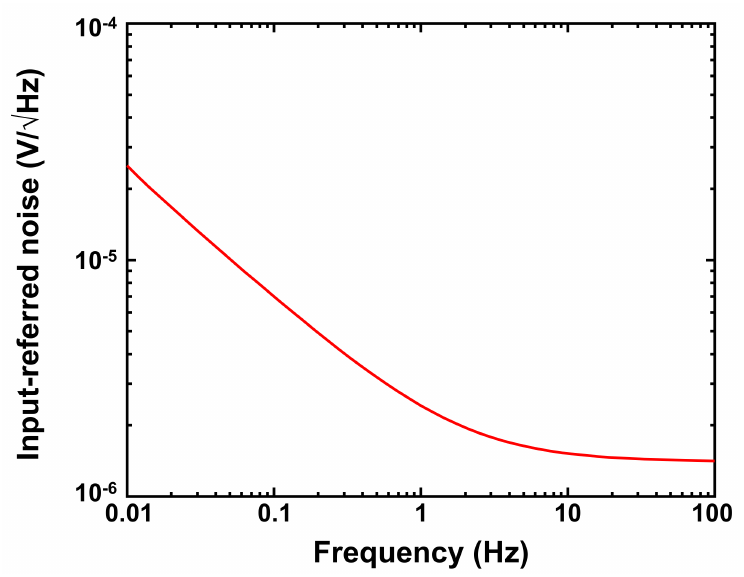
Figure 6. Simulated input-referred noise of the front-end amplifier shown in Figure 4.